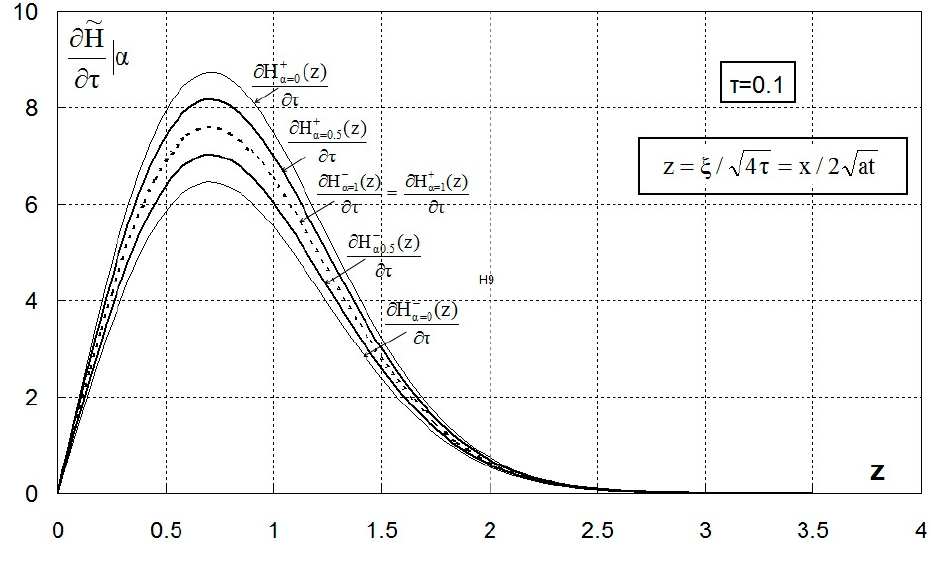
H ( z ) τ = 0.1 with respect to z, for α = 0, 0.5 and ∂ τ | )z(H~ ∂∂ (cid:101) = with respect to z, for α =0, 0.5 and 1. τ